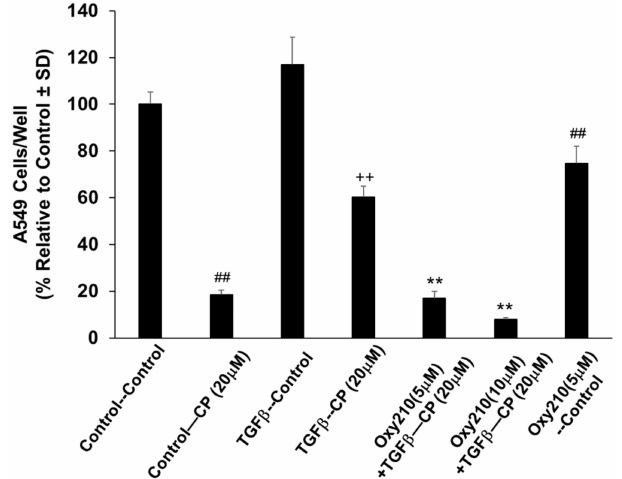
Figure 10. E ff ect of Oxy210 on TGF β -induced resistance to carboplatin. A549 cells were treated with the agents as indicated (in front of –) in RPMI 1640 containing 2% FBS for 3 days, and then treated with the agents as indicated (after –) for 4 days. The cells were then trypsinized and counted. Data from a representative experiment are reported as the mean of triplicate determinations ± SD (## p < 0.01 vs. Control–Control; ++ p < 0.01 vs. Control–CP; ** p < 0.01 vs. TGF β